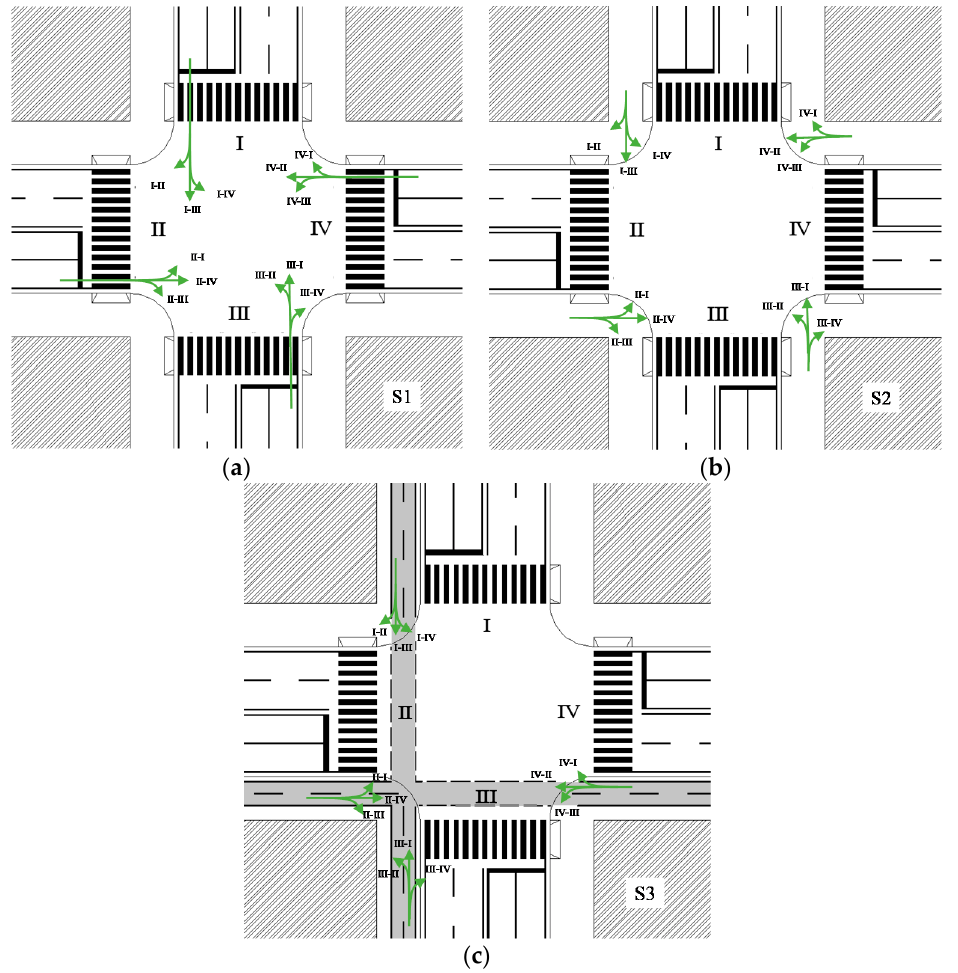
Figure 5. Layout of schemes 1 to 3 (S1–S3); ( a ) Scheme 1, ( b ) Scheme 2, and ( c ) Scheme 3.